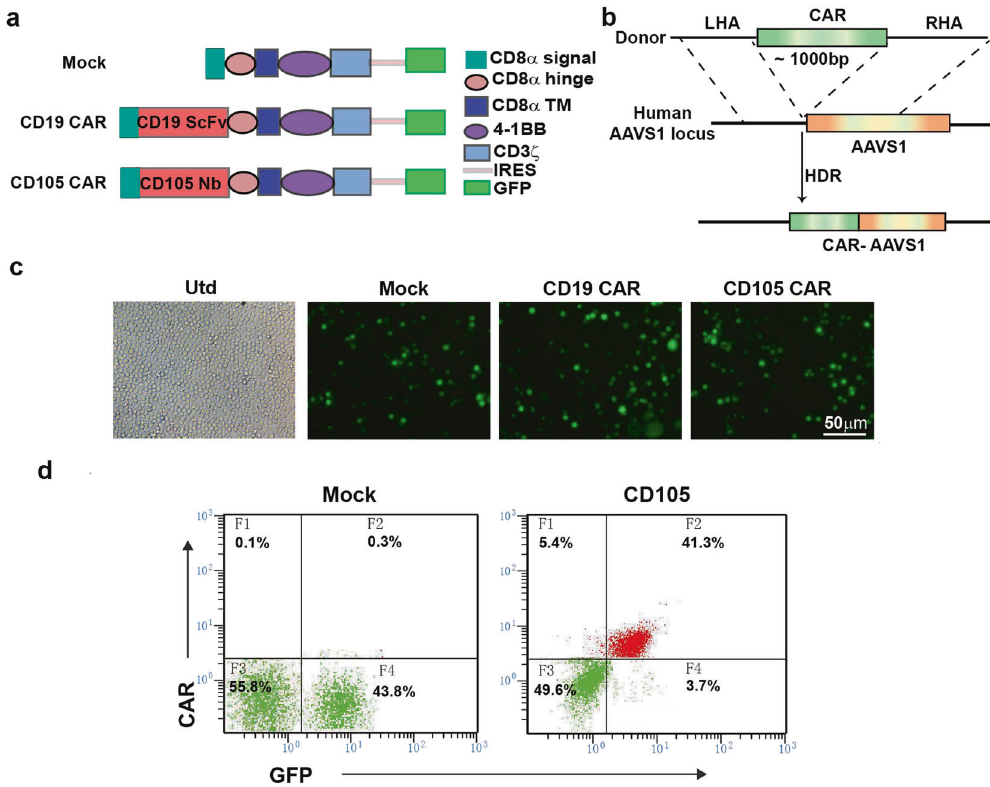
Fig. 2 Generation of CD105-chimeric antigen receptor T cells. a Schematic illustration of vector expressing CARs, CAR with the signal peptide, anti-CD105 Nanobody (C184), CD8 α hige and transmembrane domain, 4-1BB costimulatory endodomain, and CD3 ζ signaling domain along with GFP using IRES. b HDR-mediated integration of CAR into the AAVS1 locus. Top, donor containing the CAR, CRISPR/Cas9-targeted CAR gene integration into the AAVS1 locus cassette fl anked by homology arms. c Expression of GFP by fl uorescence microscope after electroporation into T cells. d CD105-speci fi c CAR expression on human T cells were analyzed using fl ow